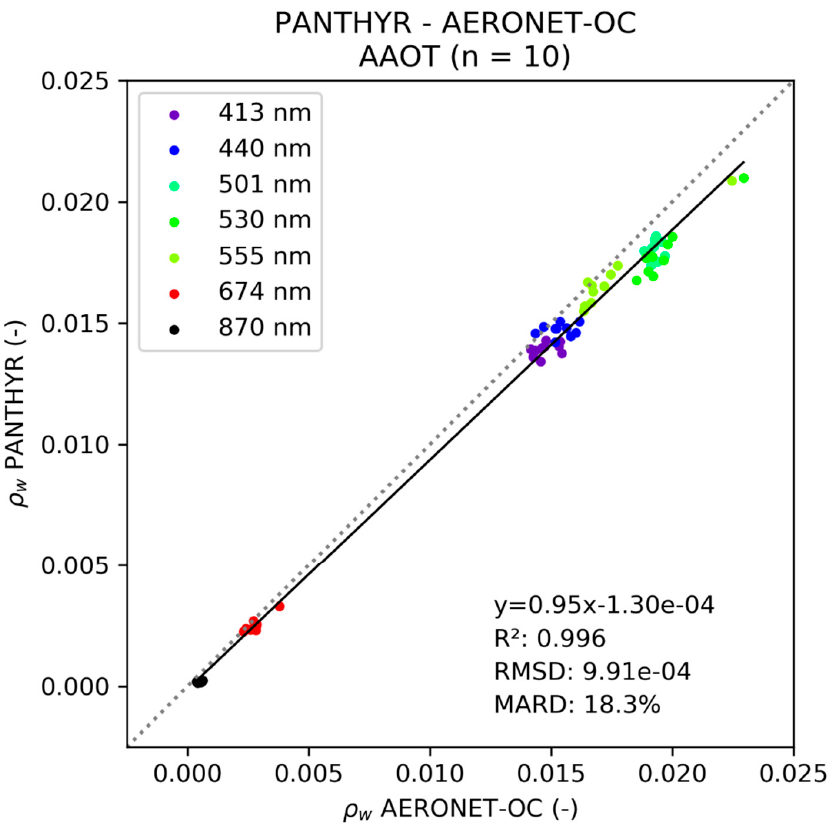
Figure 9. Scatterplot for selected wavelengths comparing PANTHYR data with AERONET-OC Venise Level 1.5 data for ρ w for 10 matchups. Linear regression statistics are given, including the root-mean-square di ff erence (RMSD) and the mean average relative di ff erence (MARD). All PANTHYR data presented in this figure were measured at the 270 ◦ relative azimuth. The black line is the reduced major axis regression. Statistics are plotted here for all wavelengths together. For per-band RMSD and MARD, see Figures 8c,d.